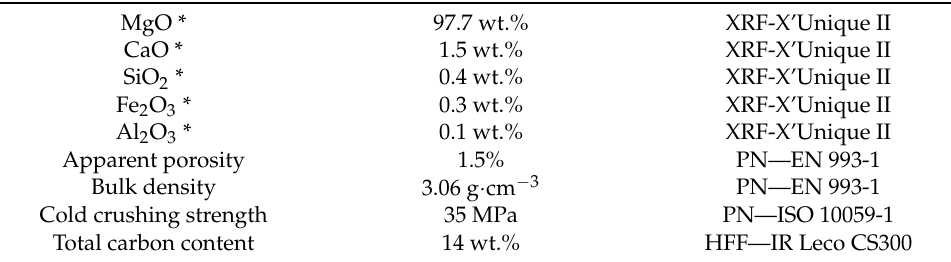
Table 1. Material properties of